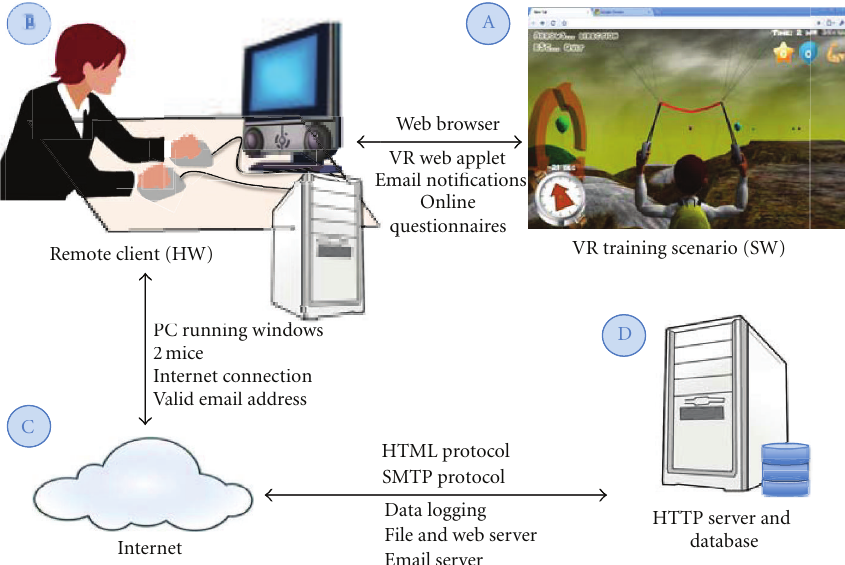
Figure 1: Neurorehabilitation Training Toolkit system architecture. (A) A web browser is used to access the application and its instruction at http://neurorehabilitation.m-iti.org/NTT/ (B) NTT can be executed on any modern PC equipped with two mice and an internet connection. (C) The NTT software is accessed freely from Internet, where the NTT servers are located. (D) A number of remote servers host the NTT site, the application itself, and are used to log user data.